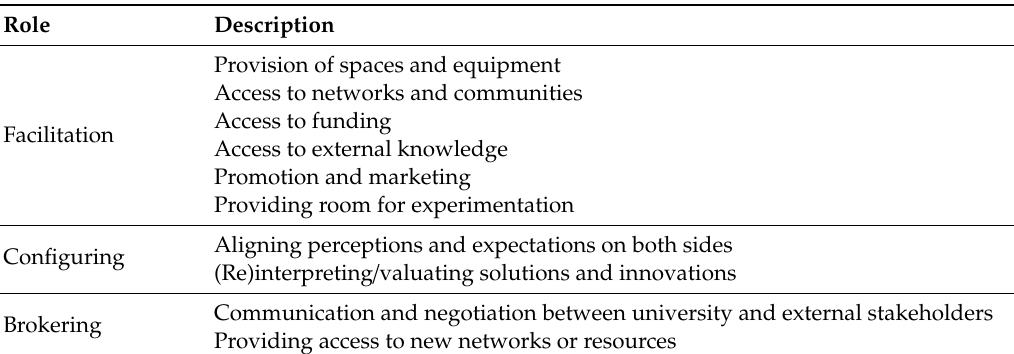
Table 1. Roles of innovation